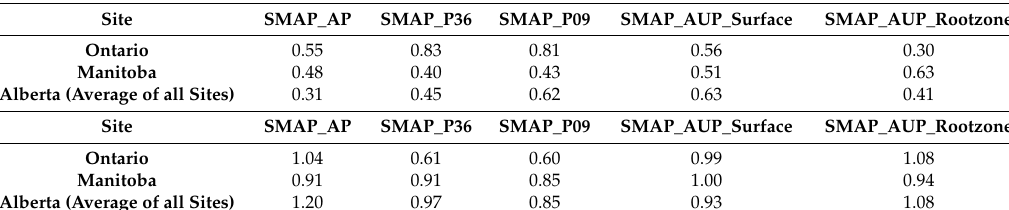
Table 4. Pearson pairwise linear correlation coefficients between SMAP soil moisture data sets and in situ measurements at 5cm depth. The values for Alberta represent the average statistics for all 33 sites in the Alberta